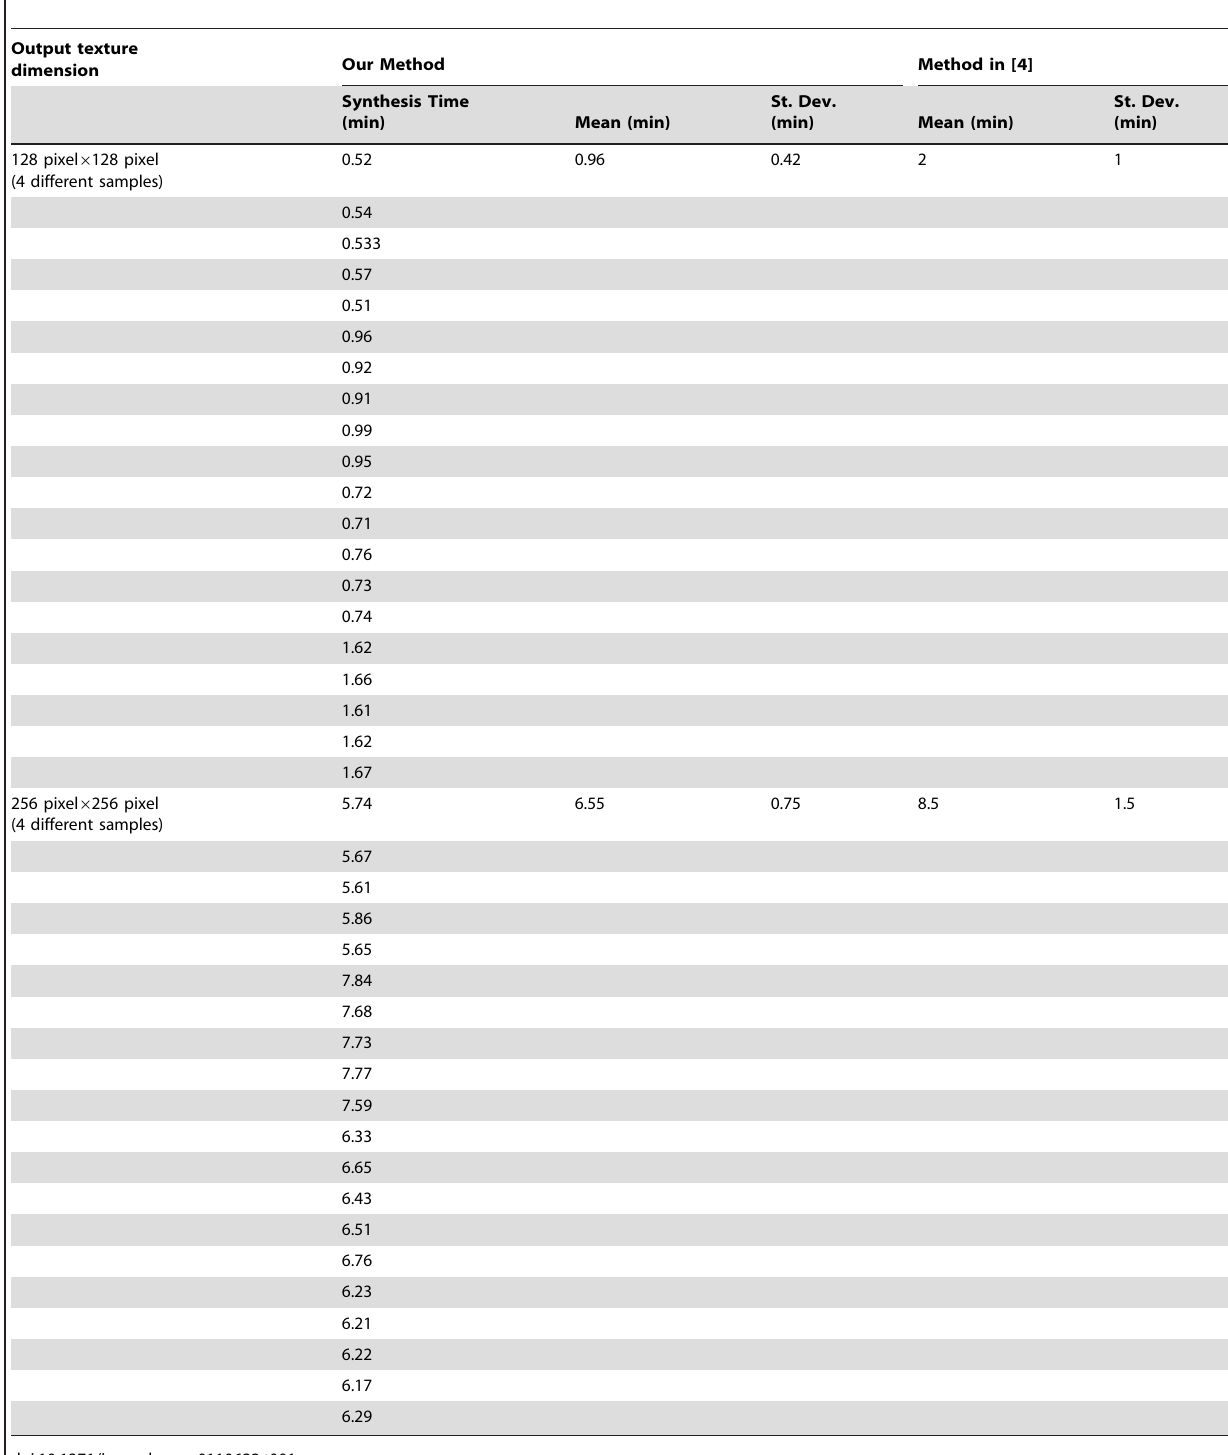
Table 1. Efficiency comparison of proposed method with the method in